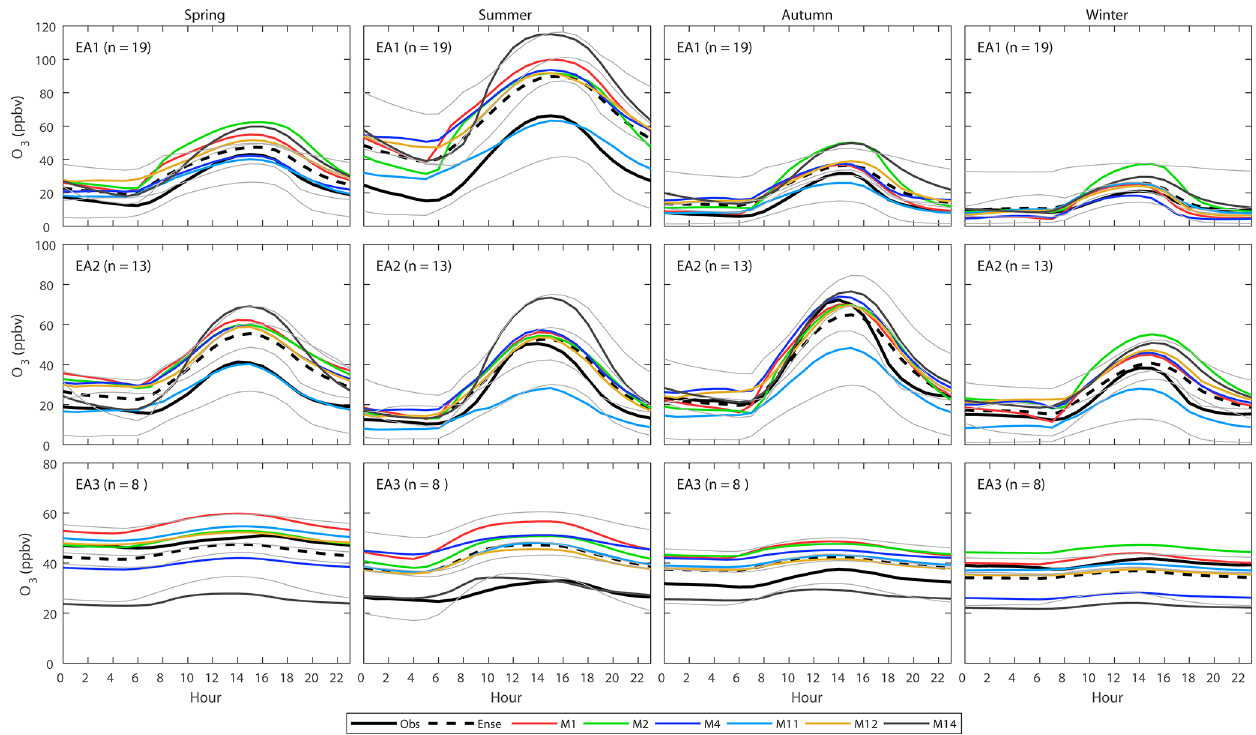
Figure 4. Seasonal mean diurnal cycle of surface O 3 , in parts per billion by volume (ppbv), as a function of hours, for all models and their ensembles, averaged across all observed stations in three subregions of East Asia: EA1 (top row), EA2 (middle row) and EA3 (bottom row). Observations are denoted by the thick black line. n represents the number of stations. The gray lines represent O 3 levels simulated by models except M1, M2, M4, M11, M12 and M14. Spring, summer, autumn and winter were defined as March–April–May, June–July–August, September–October–November and December–January–February,